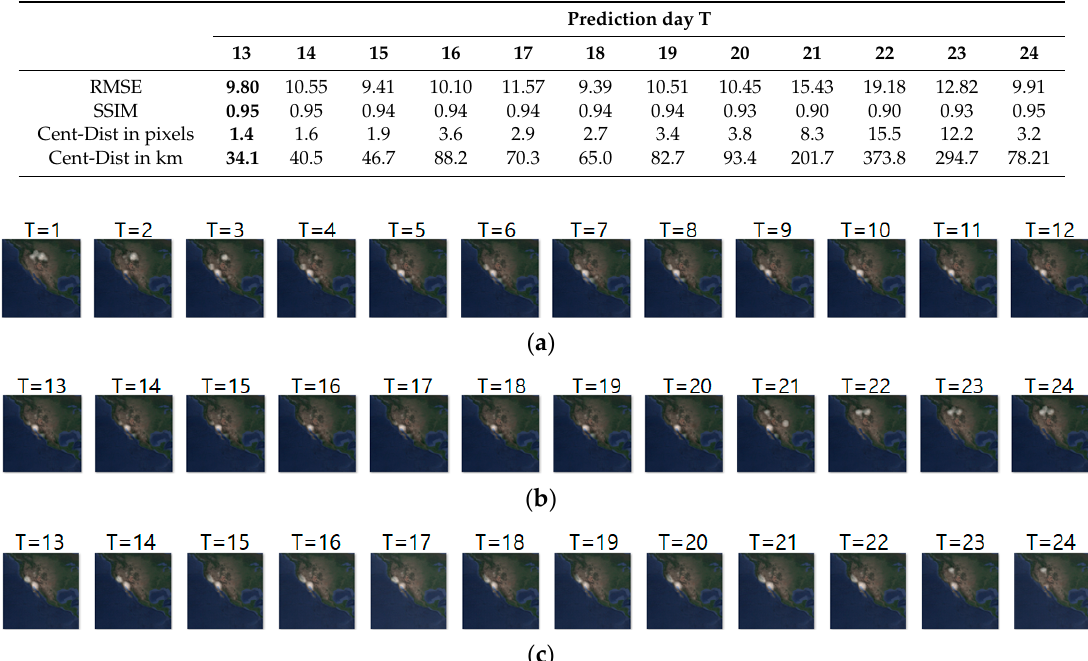
Figure 14. Movement prediction result–( a ) input sequence; ( b ) ground truth; ( c ) predicted sequence.